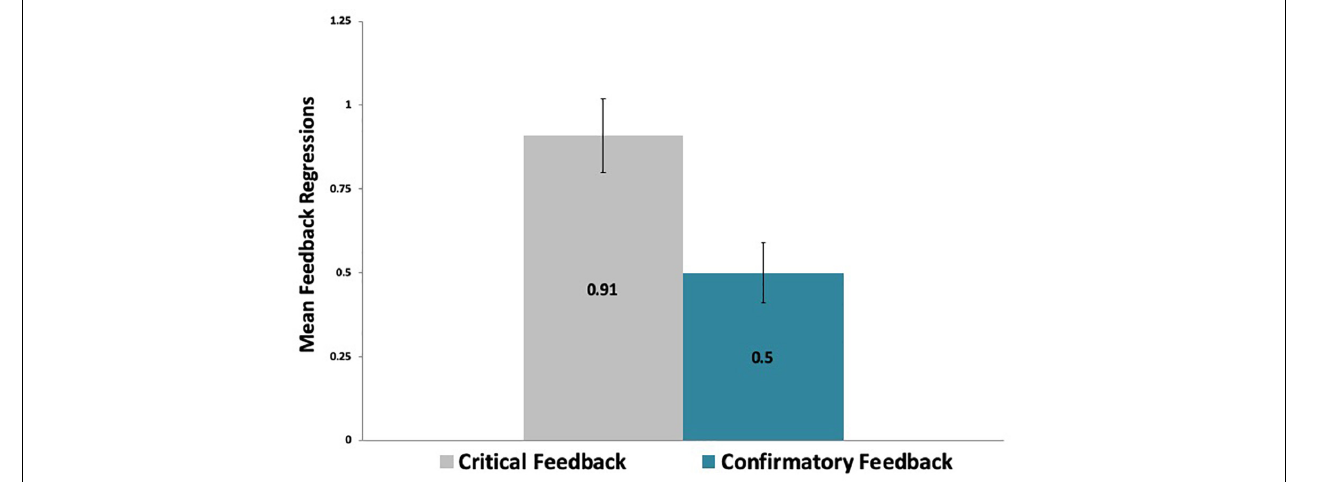
FIGURE 7 | Participants revisited critical feedback messages significantly more often than confirmatory